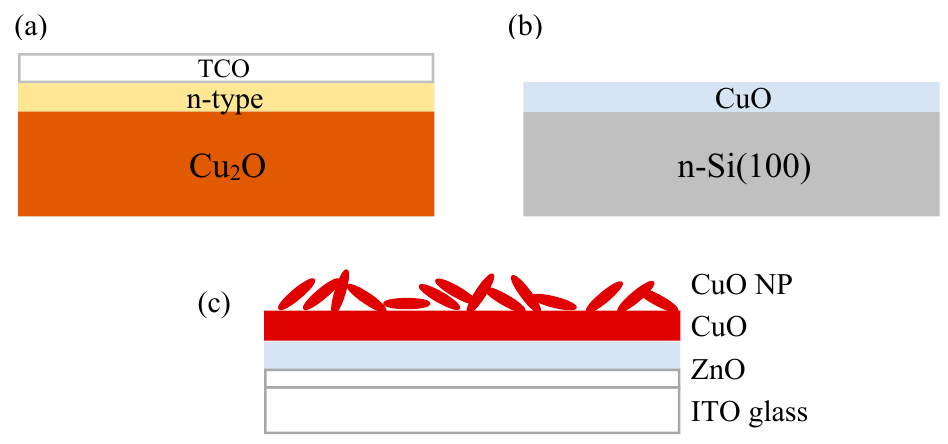
Figure 3. Schematic device structure for ( a ) Cu 2 O/ZnO heterojunction solar cell; ( b ) CuO/n-Si heterojunction solar cell; and ( c ) CuO/ZnO heterojunction solar cell enhanced by mixed phase CuO/Cu 2 O nanopowder.